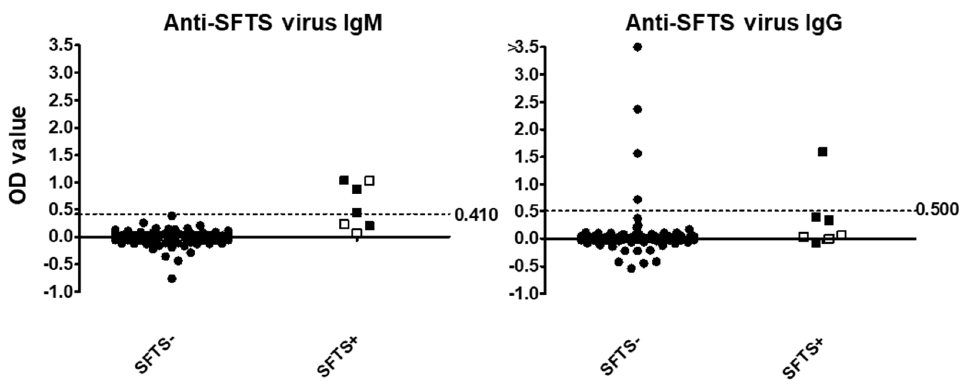
Figure 1. Detection of anti-SFTSV antibodies in dog sera. OD values of the ELISA are plotted. Broken lines indicate the cut-off value. Left figure shows the plot of the OD values of the IgM ELISA, while the right figure shows the plot of the OD values of the IgG ELISA. Dogs were divided into two groups, SFTSV + or -, according to the results of RT-PCR for SFTSV. Open boxes indicate dogs that died due to SFTS infection. Table 3. Changes in antibody titers in dogs with